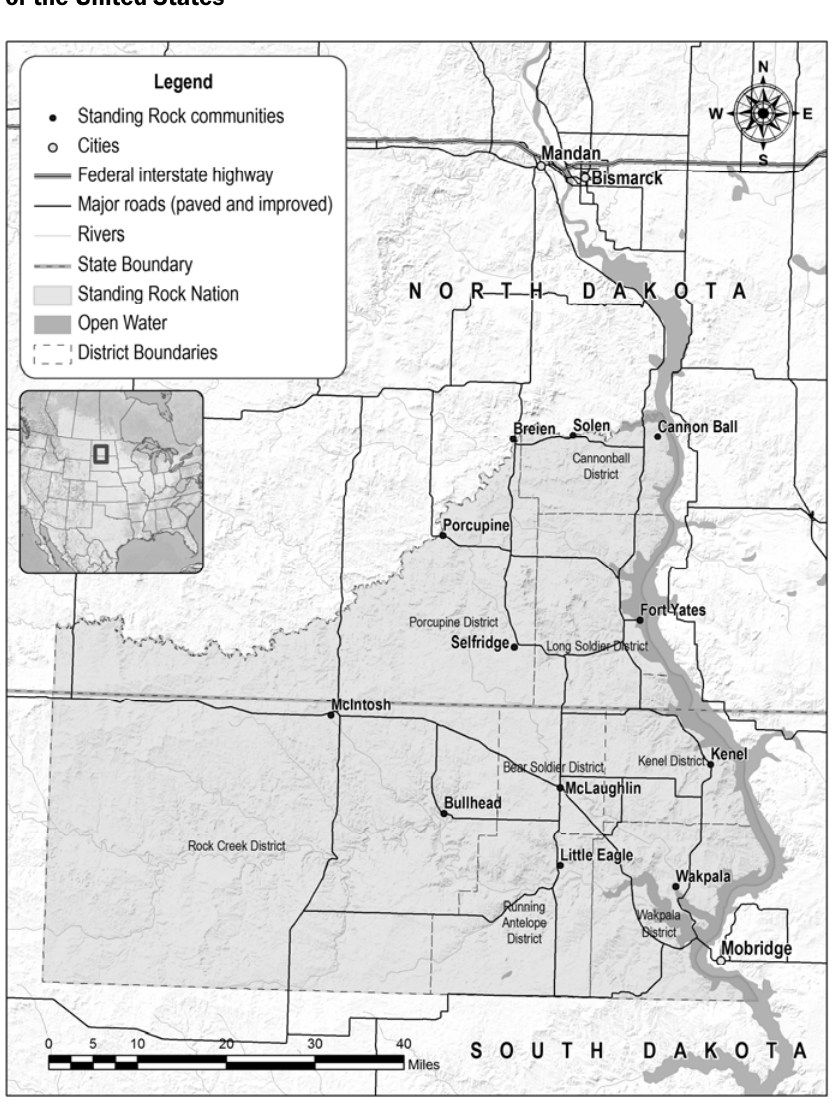
Figure 1. The Standing Rock Nation in the Northern Great Plains of the United